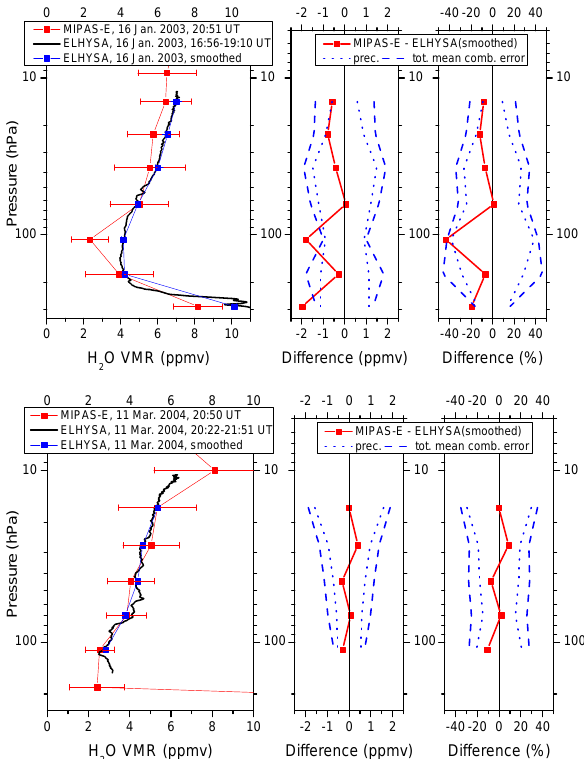
Fig. 4. Comparison between MIPAS-E (red squared line) and ELHYSA (black solid line) measured H 2 O profiles from 16 January 2003 (top) and 11 March 2004 (bottom) at Kiruna (~68°N) along with absolute and relative differences (blue squared lines) and combined errors (blue dotted and dashed lines). The in-situ ELHYSA profile was smoothed with the averaging kernel of MIPAS-E (blue squared line) to make the vertical resolution of both instruments comparable.